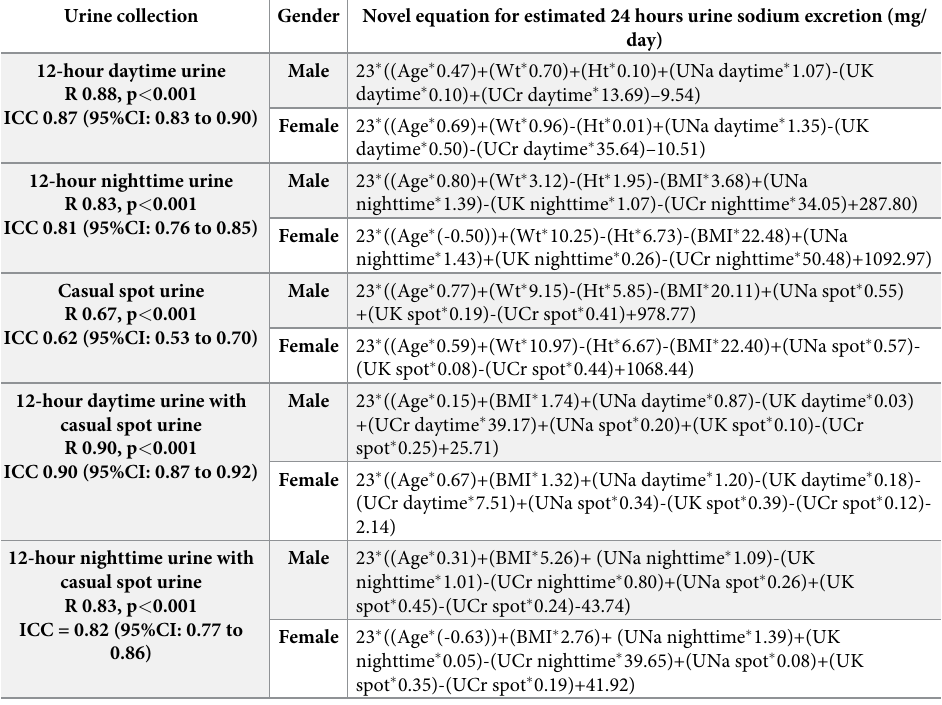
Table 3. Derived novel equation for estimating 24 hours urine sodium